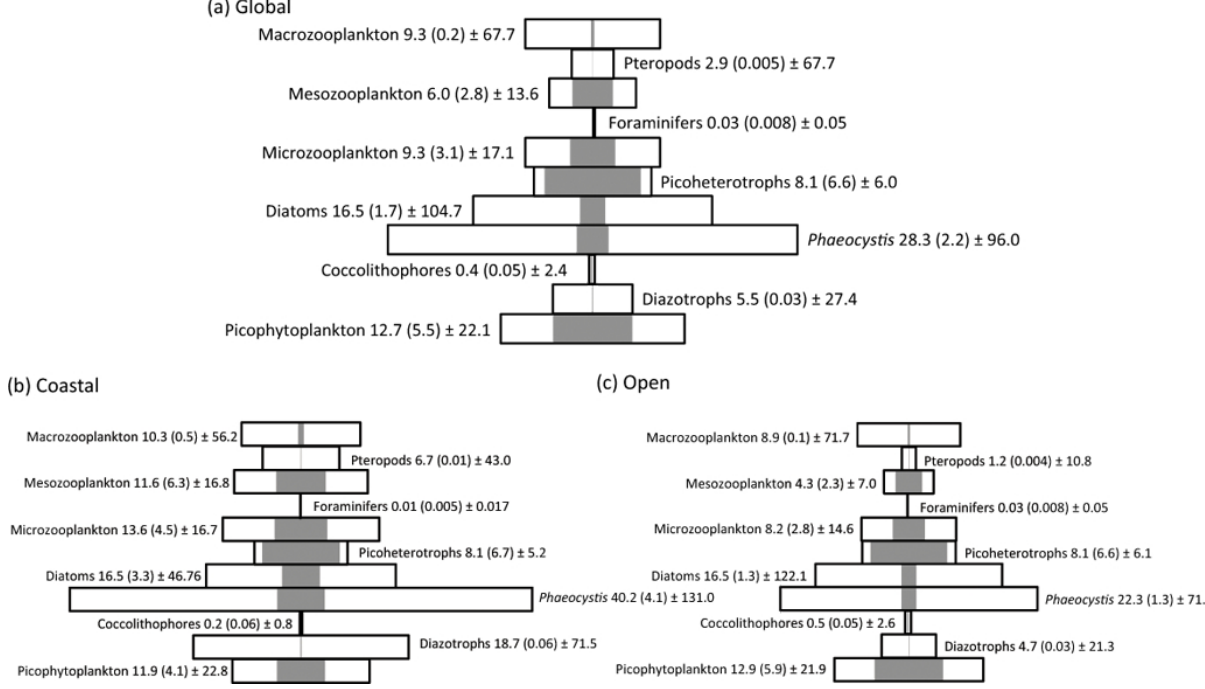
Figure 5. Trophic pyramid of autotrophic and heterotrophic PFTs. Mean (black outline) and median (grey fill, values in brackets) biomass ( µ gCL − 1 ) in the top 200m for each of the PFTs presented in the MAREDAT special issue. Standard deviation is listed but not shown in the graph. (a) Global ocean (for full details see Table 2, (b) coastal and (c) open